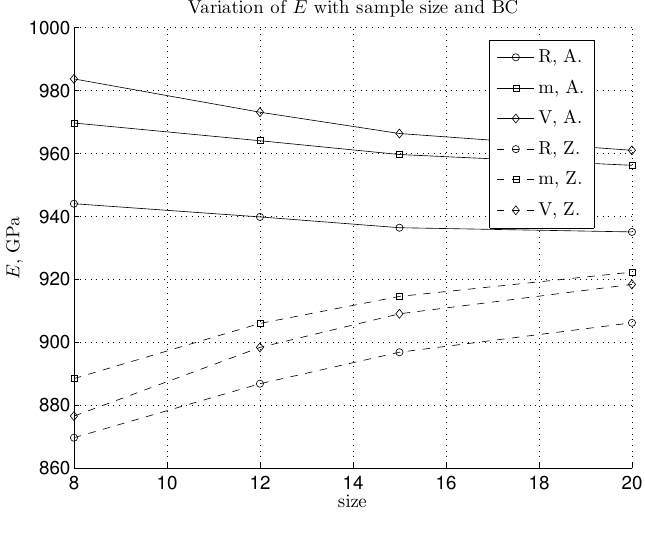
Figure 4. The change of Young’s modulus with respect to the size of the lattice specimen based upon the harmonic potential.